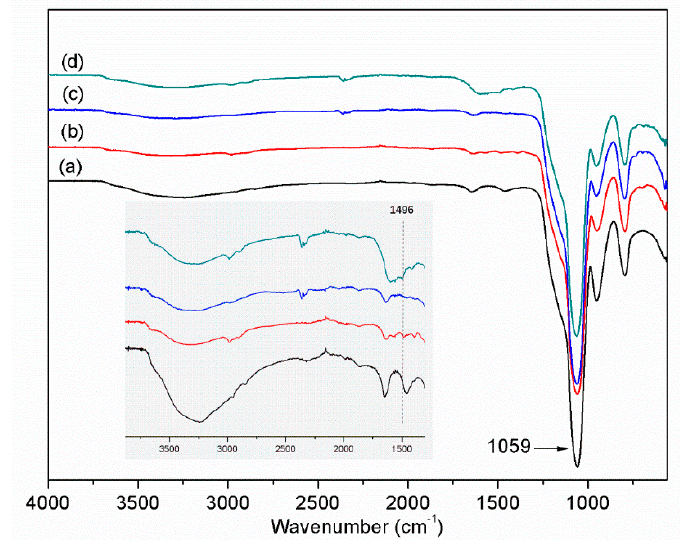
Figure 3. FT-IR spectra of ( a ) Si, ( b ) Si@NH 2 , ( c ) Si@BA, and ( d ) HRP–MIP.